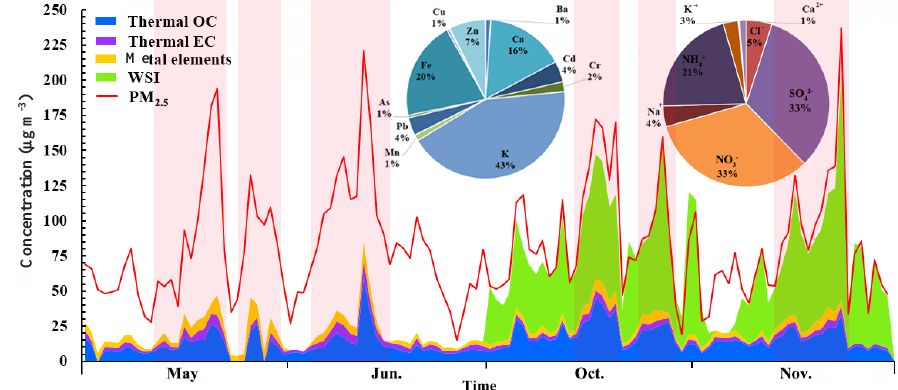
Figure 3. Daily variations of PM 2 . 5 and its components. Pie charts represent the composition of elements and water-soluble ions, respectively. Pink shaded areas represent episodes.